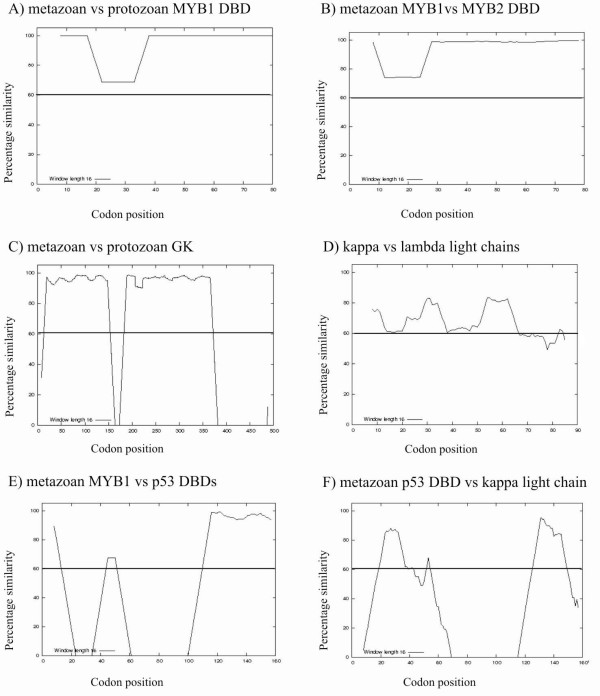
FIRE plots. Plots represent the pairwise alignment of ω MLEs at codon sites with FIRE, recorded as a percent similarity between the two values. Corresponding FIRE scores and alignments are in TABLE 1 and additional file 3, respectively. A sliding window of 16 codons was used and the percent similarity is the average over the window. (A) conserved orthologous metazoan and protozoan MYB1 DBDs; (B) conserved paralogous metazoan MYB1 and MYB2 DBDs; (C) conserved metazoan and protozoan GK; (D) κ and λ light chain antibodies; (E) metazoan MYB1 and p53 DBDs; and (F) p53 DBD and κ light chain antibody. The sequence sets used in plots E and F have no functional similarity and represent negative controls. The 60% similarity cut-off value is indicated by a solid line. DBD = DNA-binding domain; GK = glycerol kinase.